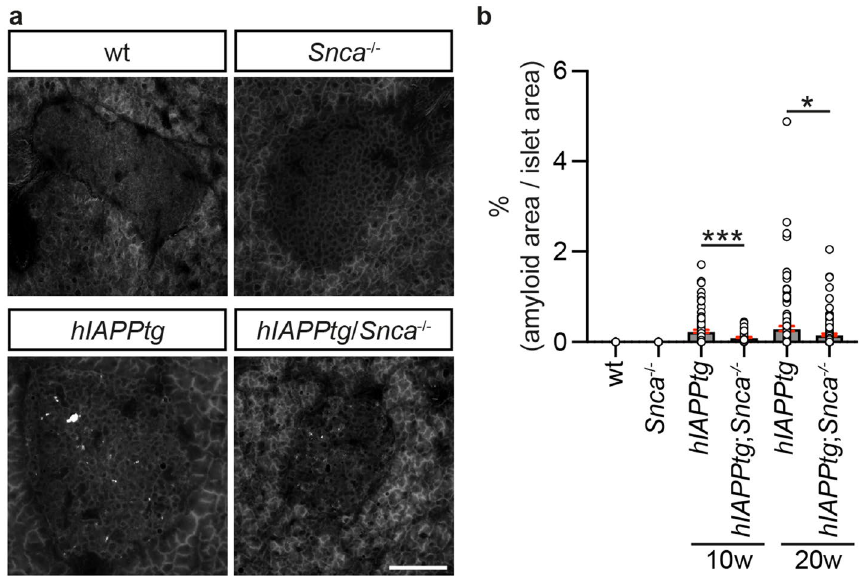
Figure 5. Reduced amyloid formation in hIAPPtg mice devoid of endogenous αSyn. (a) Representative images of Thio-S + amyloid deposits in islets from 10 weeks old wild type (wt), Snca −/− , hIAPPtg , and hIAPPtg;Snca −/− mice. ( b ) Quantification of percentage Thio-S + amyloid area/islets area from 10 weeks old wt and Snca −/− mice and 10 and 20 weeks old hIAPPtg and hIAPPtg;Snca −/− mice. Please see “Amyloid analyses” in the Materials